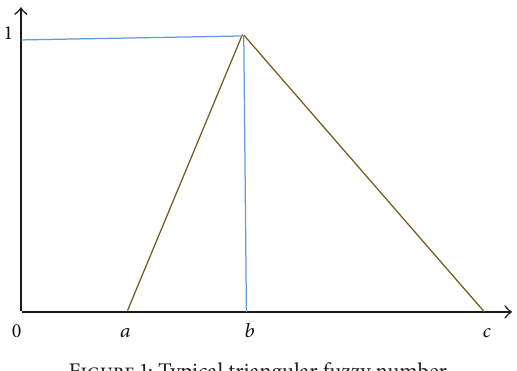
Figure 1: Typical triangular fuzzy